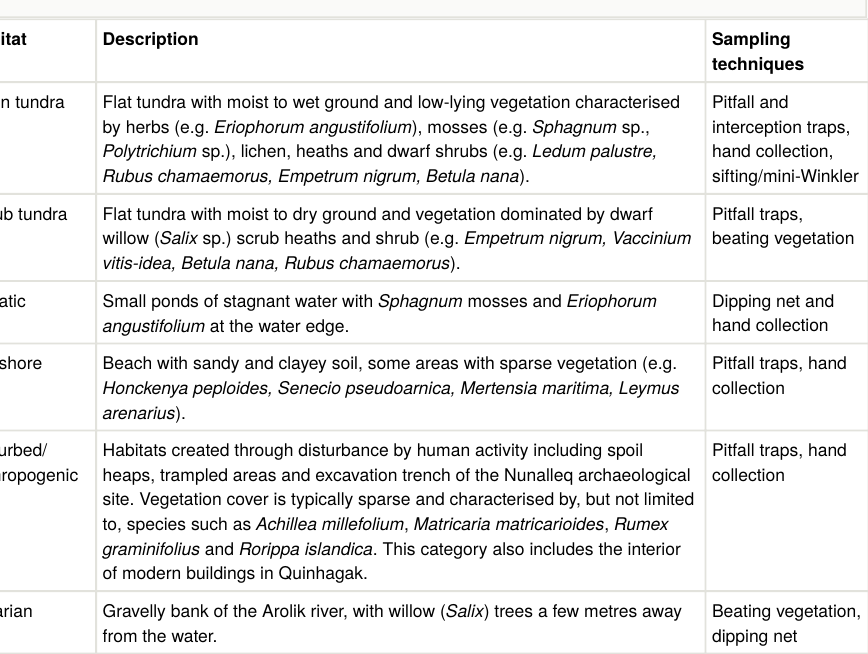
techniques Pitfall and interception traps, hand collection, sifting/mini-Winkler Pitfall traps, beating vegetation Dipping net and hand collection Pitfall traps, hand collection Pitfall traps, hand collection Beating vegetation, dipping net